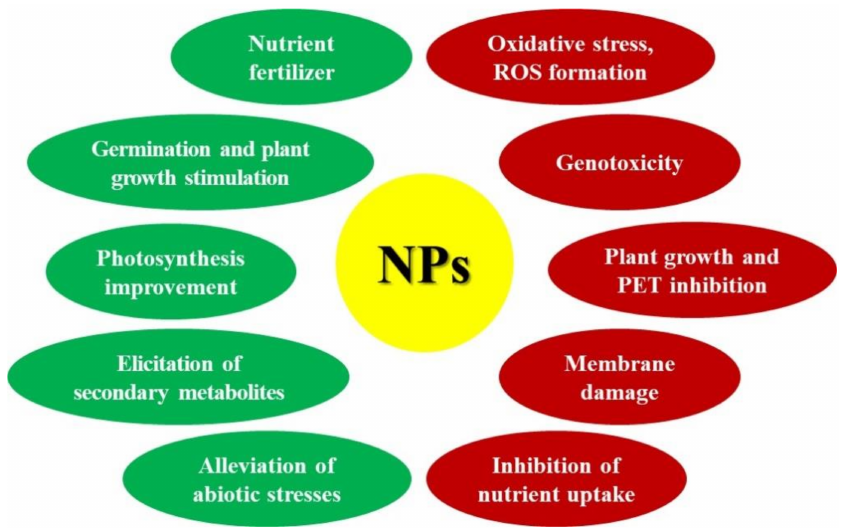
Figure 2. Beneficial and adverse effects of NPs on medicinal and aromatic plants.